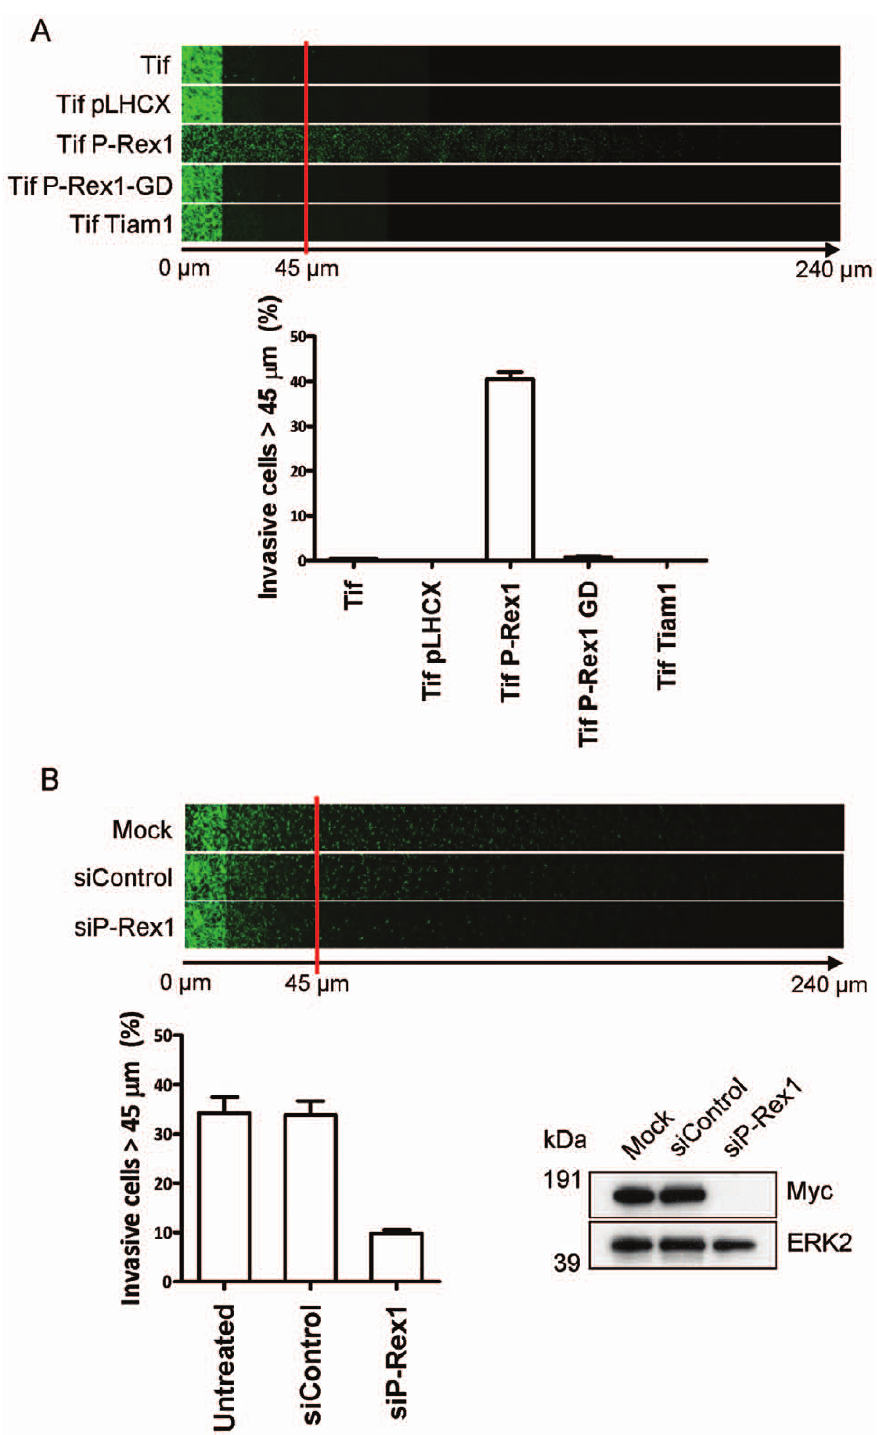
Figure 3. Expression of P-Rex1 promotes invasive behaviour of human fibroblasts. (A) Invasive migration of parental (Tif) and control vector (Tif pLHCX) orRacGEF expressing immortalised human fibroblasts into Matrigel plugs was determined by inverted invasion assay. Serial optical sections of Calcein-AM stained invasive cells were captured at 15 m m intervals by confocal microscopy and depicted as a montage of successive sections at increasing depth from left to right, as indicated. Invasive migration was quantified by measurement of fluorescence intensity of cells penetrating the matrix to a depth of 45 m m and beyond, and expressed as a percentage of the total fluorescence intensity of all cells within the assay. (B) Invasive migration of P-Rex1 expressing immortalised human fibroblasts transfected with non-targeting control or P-Rex1-specific siRNA oligonucleotides, with quantification as above ( 6 SEM, *** P , 0.0001 Unpaired t-test, 3 independent experiments).